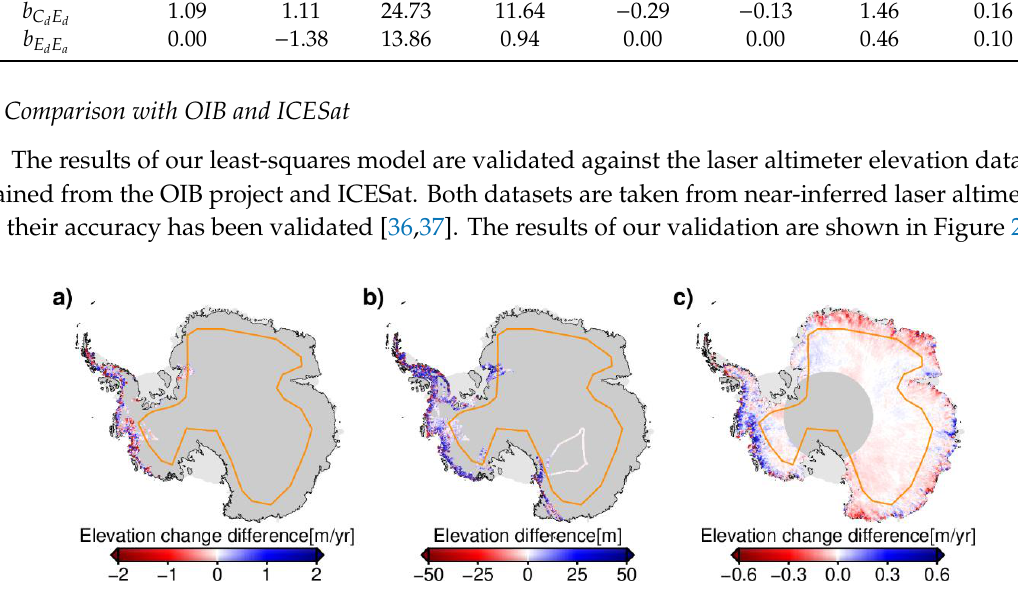
Table 1. Statistics of the total intermission biases and the intramission A–D bias of Envisat and CryoSat-2 at the intersections of Envisat’s ascending tracks and descending tracks over the CryoSat-2 LRM and SARIn mask areas. The number of intersections is 51,221 in the Low-Resolution Mode (LRM) mode area and 15,476 in the SARIn mode area. The median, mean, RMS, and the 10th and 90th percentile range (P 90 –P 10 ) of the biases are given. Table 2. Statistics of the comparison between elevation changes derived from the combined elevation time series and those from Operation IceBridge (OIB) observations. The mean and RMS of the differences between elevation changes over the AIS and CryoSat-2 LRM and SARIn mask areas, as well as those acquired before 2010, after 2010, and from 2002 to 2016, are given. Note that the intercomparison results are mainly concentrated along the outlet glaciers of West Antarctica and the Antarctic Peninsula. Different Regions Difference Periods